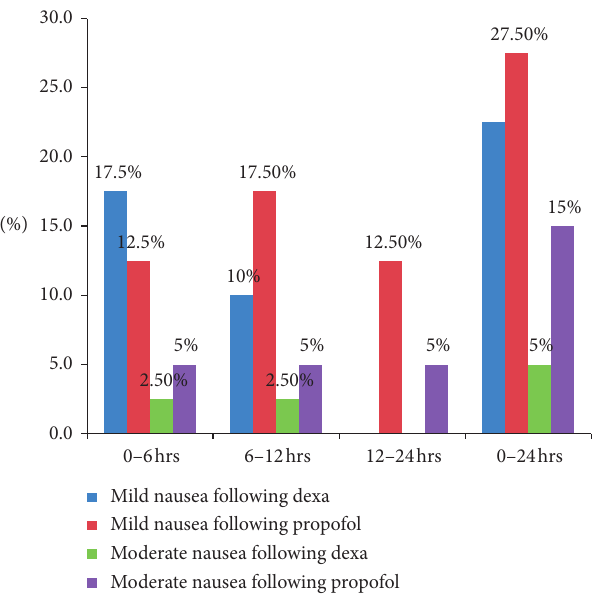
Figure 3: Comparison of postoperative nausea severity using 11- point NRS score